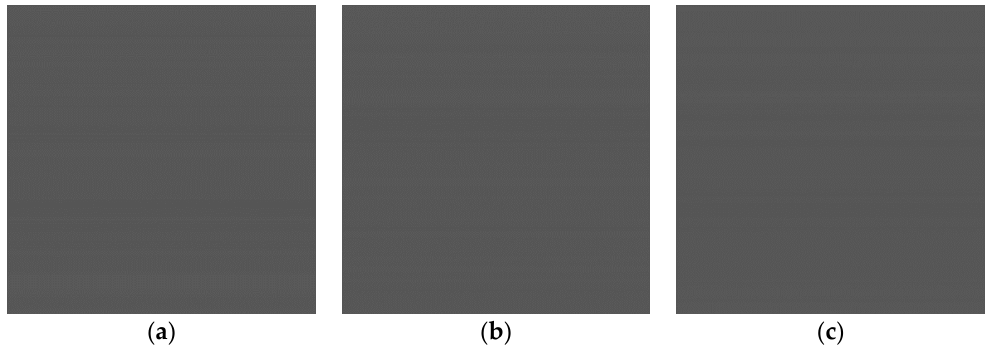
Figure 15. Correction result image of the evaluation image of Figure 10b with the modulated ‐ mode output of various ICS radiation. ( a ) modulated ‐ mode ICS ‐ 1000; ( b ) modulated ‐ mode ICS ‐ 3000; ( c ) modulated ‐ mode ICS ‐ 5000.